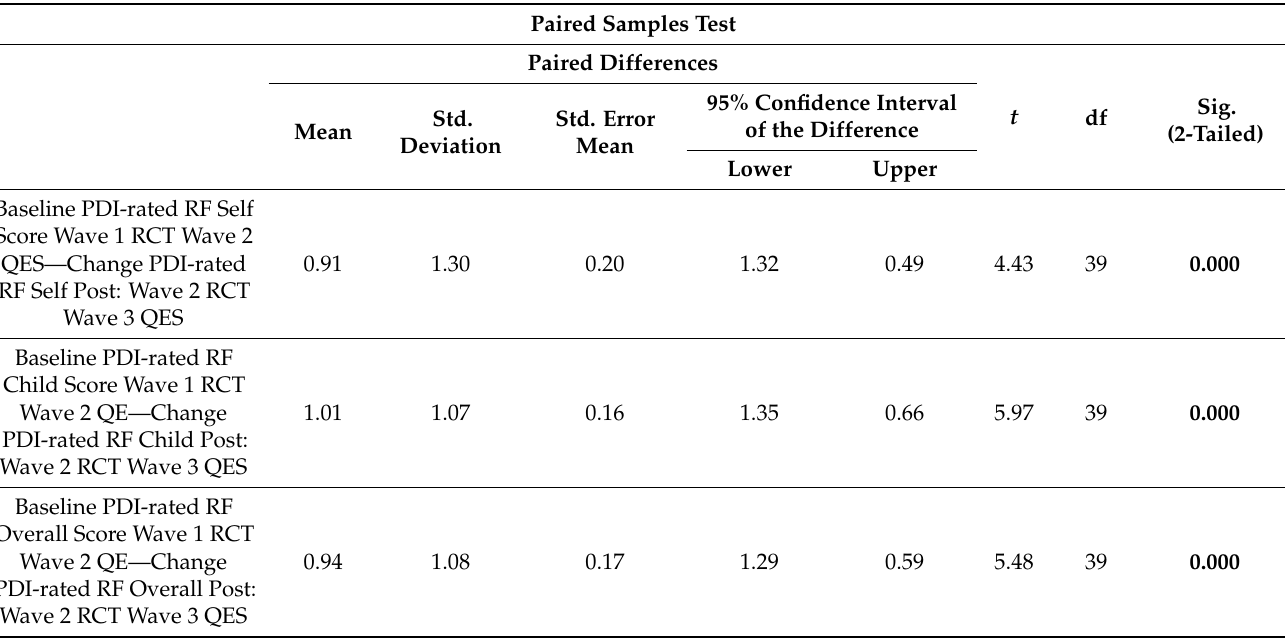
Table 5. Effects of the ATTACH TM intervention on reflective function (PDI-rated RF Self, Child, and Overall Scores) within-person